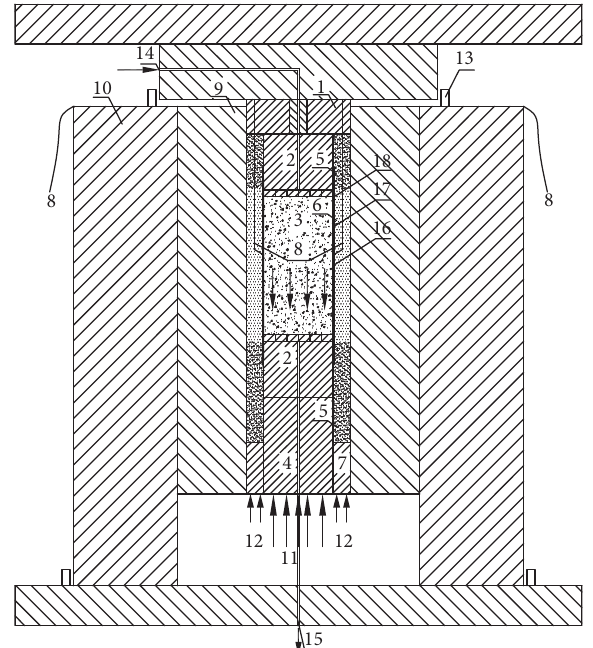
Figure 2: Schematic sample assembly in HTHP vessel. 1, cover; 2, secondary axial pressure pad; 3, sample; 4, main axial pressure pad; 5, pyrophyllite powder; 6, sodium chloride; 7, confining pressure pad; 8, thermocouple; 9, pressure vessel interior layer; 10, pressure vessel outside layer; 11, axial pressure; 12, confining pressure; 13, AE receiver; 14, gas inlet; 15, gas outlet; 16, red copper sheet; 17, phlogopite sheet; 18, heating resistor